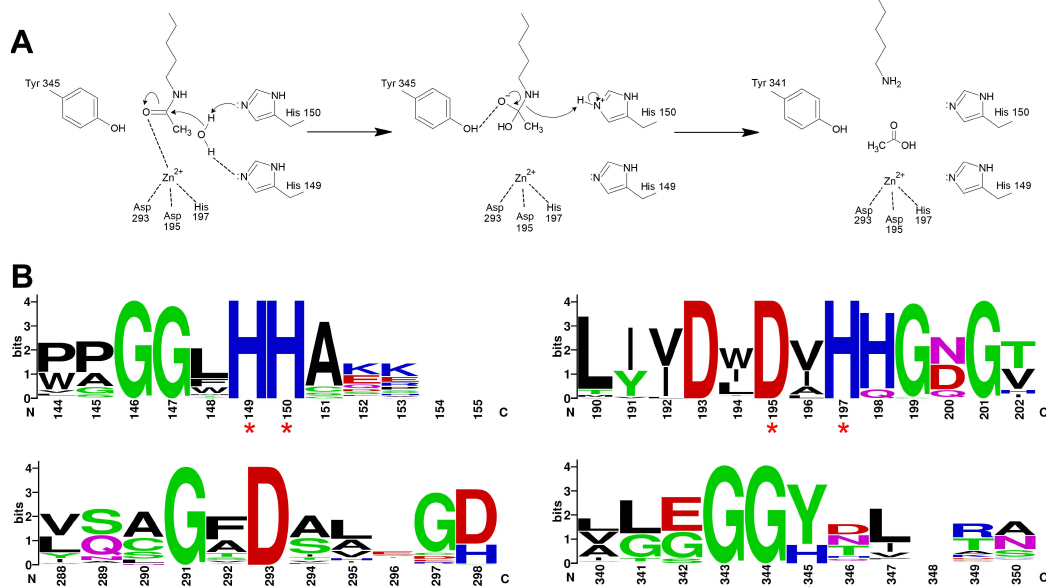
Figure 3. Catalytic action of HDACs. ( A ) Proposed mechanism of acetyl-lysine hydrolysis catalyzed by HDACs. ( B ) Sequence conservation of four regions containing the key catalytic amino acids (red asterisks) between all HDACs of the model species used for the phylogenetic tree in Figure 1. Residue Y345 is replaced by an H only in vertebrate Class IIa